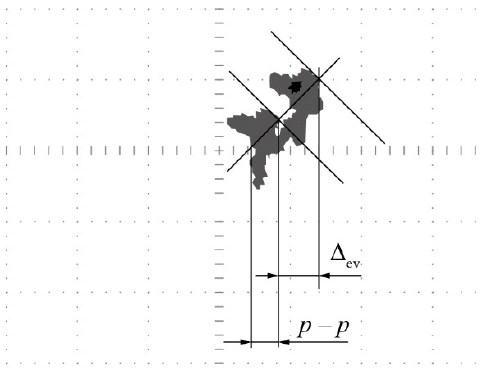
Figure 18. Figures of a pair of sensors with shift by π /2 at deflection { Δ 1 = 0.00; Δ 2 = − 0.035; Δ 3 = − 0.015} before and after increasing the head–shaft distance by 0.09 mm: CH1 = CH2 = 500 mV/DIV, Δ ev —change of the average value, | p − p |—maximum value of the elliptical part of the figure.